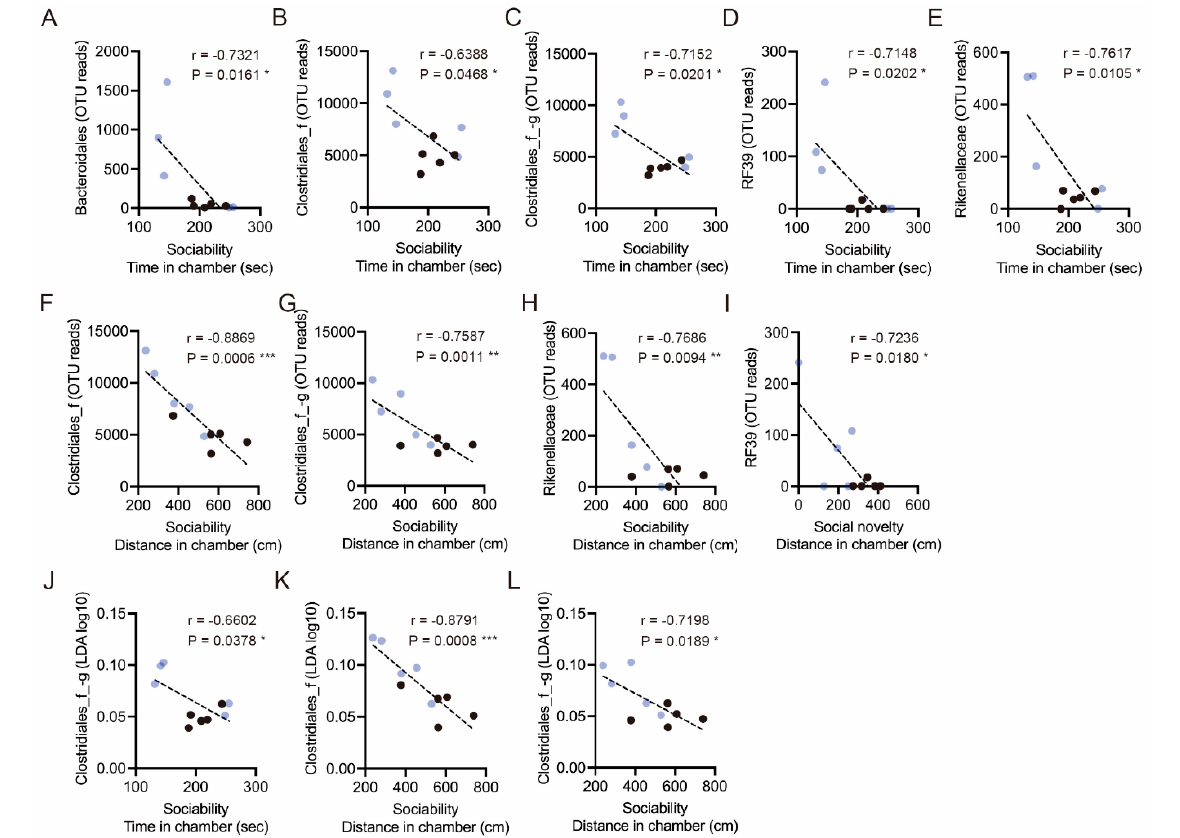
Figure 4. Correlations between gut microbiota and social behaviors. ( A – E ) Correlations between the OTU reads of Bacteroidales , Clostridiales, Mollicutes RF39, and Bacteroidales Rikenellaceae with time in the chamber during the sociability period. ( F – H ) Correlations between the OTU reads of Clostridiales and Bacteroidales Rikenellaceae with distance in the chamber. ( I ) A correlation between the OTU reads of Mollicutes RF39 with distance in the chamber during the social novelty period. ( J ) A correlation between the LDA score of Clostridiales with time in chamber during the sociability period. ( K , L ) Correlations between the LDA scores of Clostridiales with distance in the chamber. Individual black and blue dots indicate control and ELS mice, respectively. Asterisks indicate *** p < 0.001, ** p < 0.01, * p < 0.05, Pearson’s r, n = 10 ( n = 5/condition).